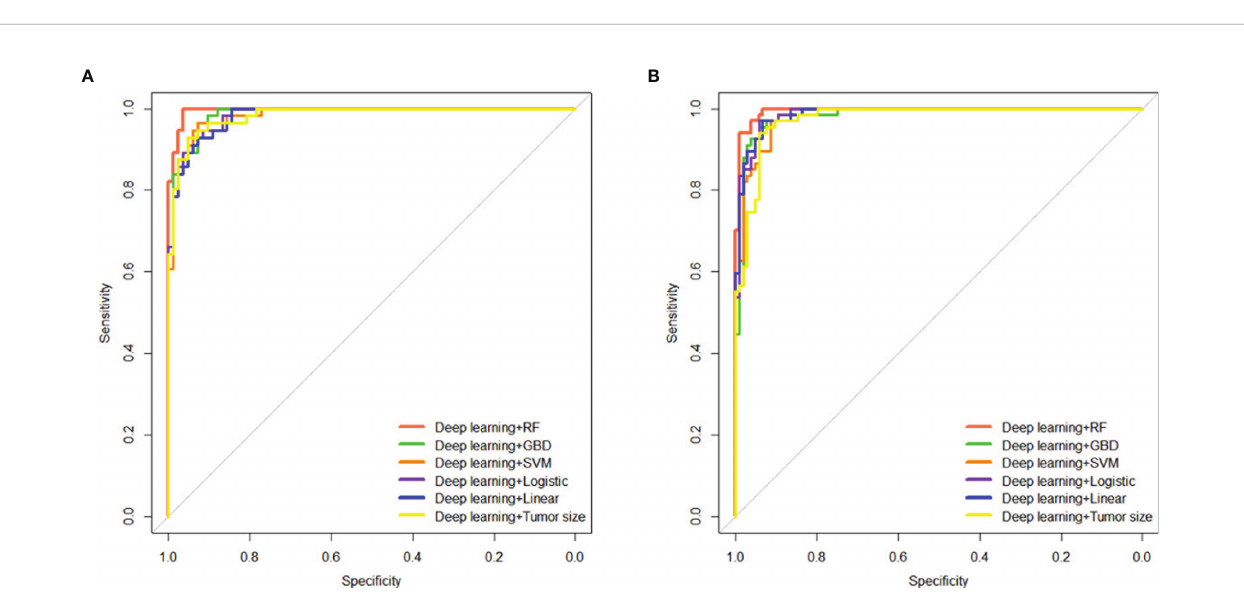
FIGURE 5 | Integrating tumor size, cML models, and DL model to predict initial treatment response. Predictive performances of the ensemble model, including tumor size and the cML and DL models, are shown as ROC curves for the training (A) and validation (B) cohorts. cML, conventional machine learning; DL, deep learning; ROC, receiver operating